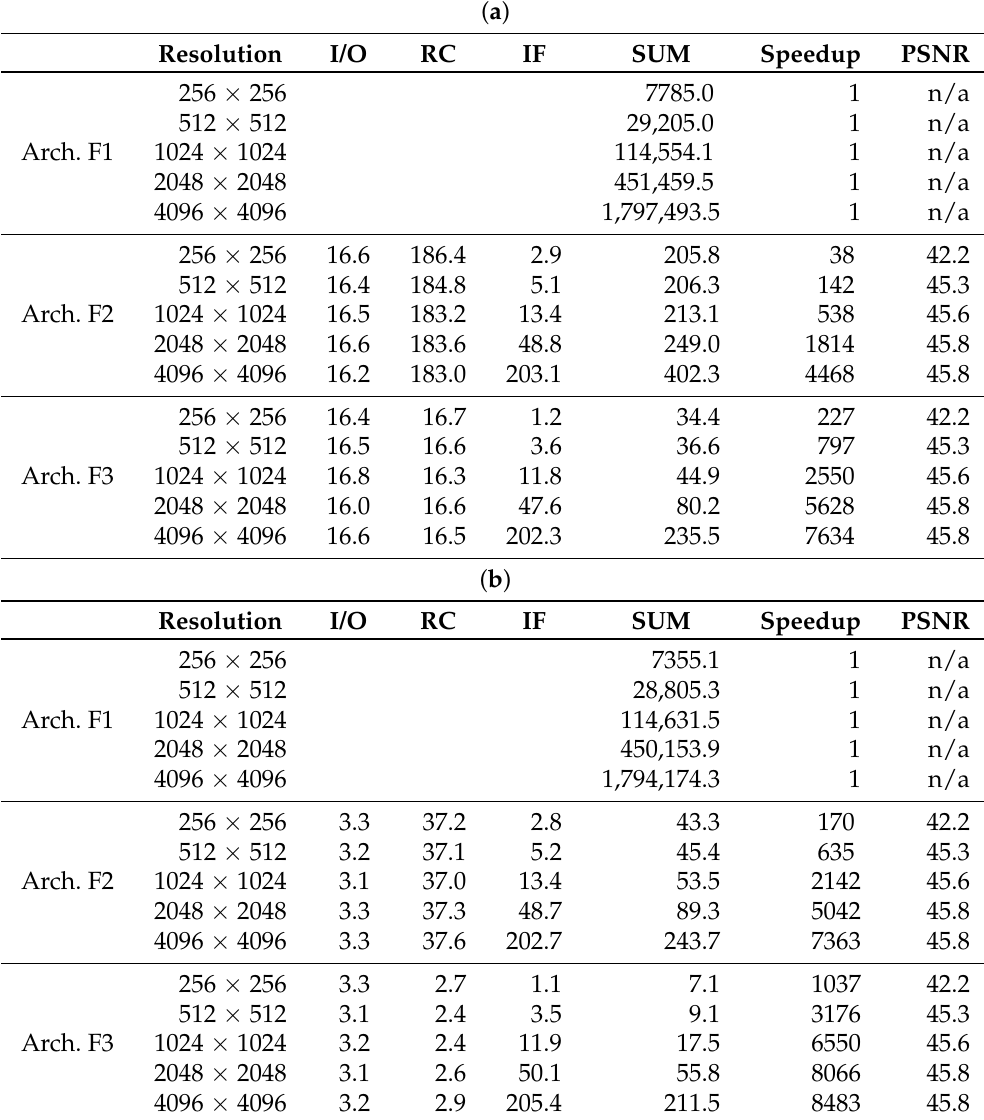
Table 6. Processing times in BP-VISAR architectures with full-aperture processing. ( a )